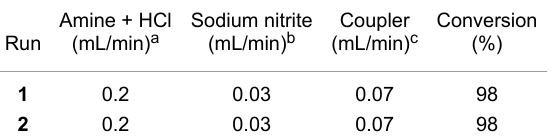
Table 6: Confirmatory experiment for the chosen reaction parameters for the synthesis. Amine + HCl Run (mL/min)